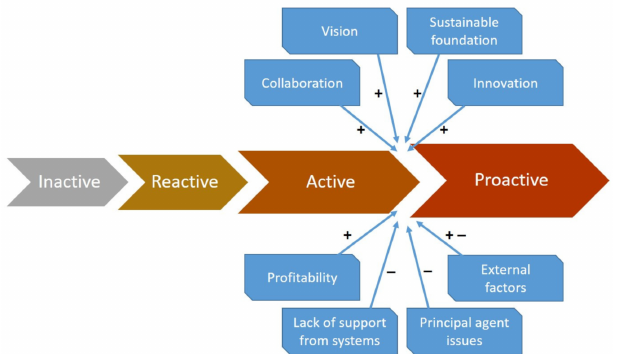
Figure 1. Conceptual model showing influencing factors having a positive (+) and/or negative ( − ) effect on the transition from the active phase to the proactive phase (based on